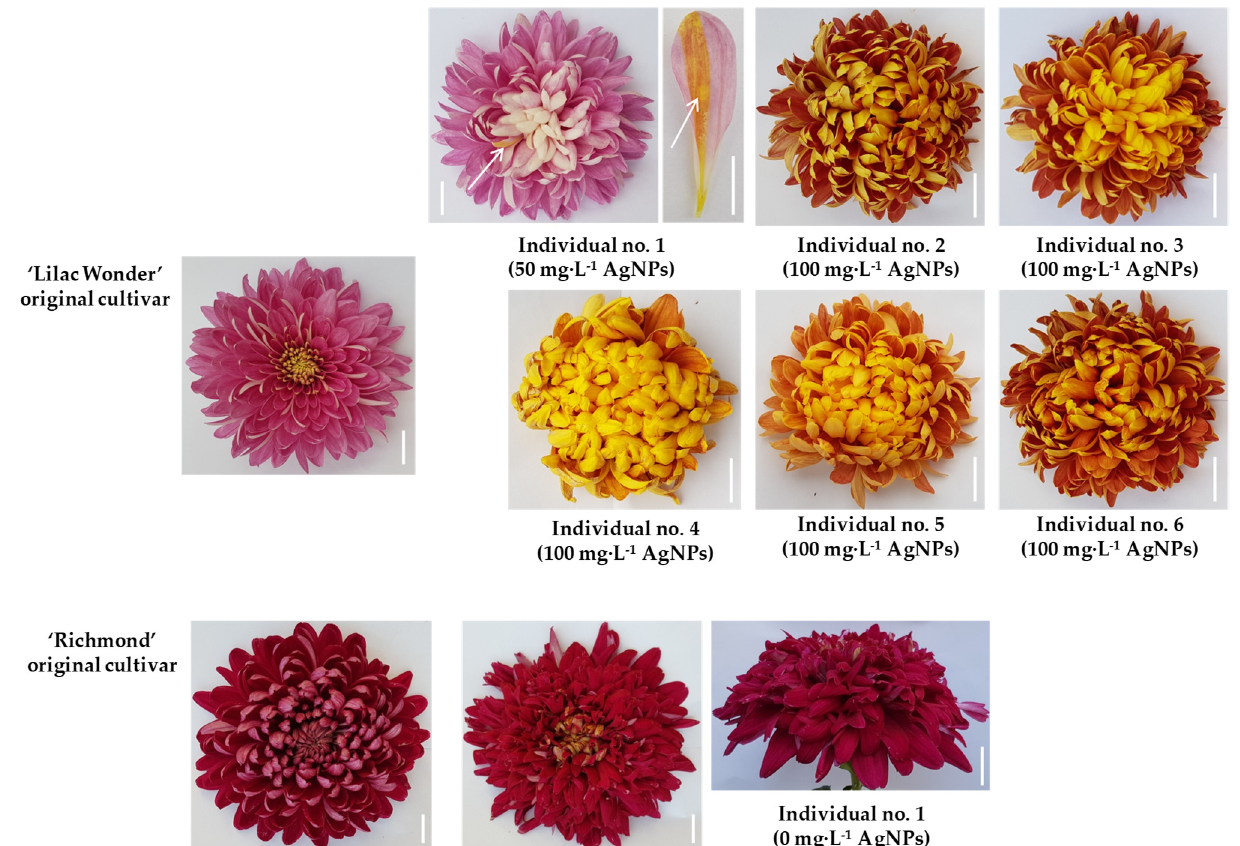
Figure 6. Chrysanthemum × grandiflorum ‘Lilac Wonder’ and ‘Richmond’ and their mutants, created as a result of AgNPs treatment (0–100 mg·L − 1 ); arrows indicate a chimeric structure of the ligulate floret; bar = 1 cm.